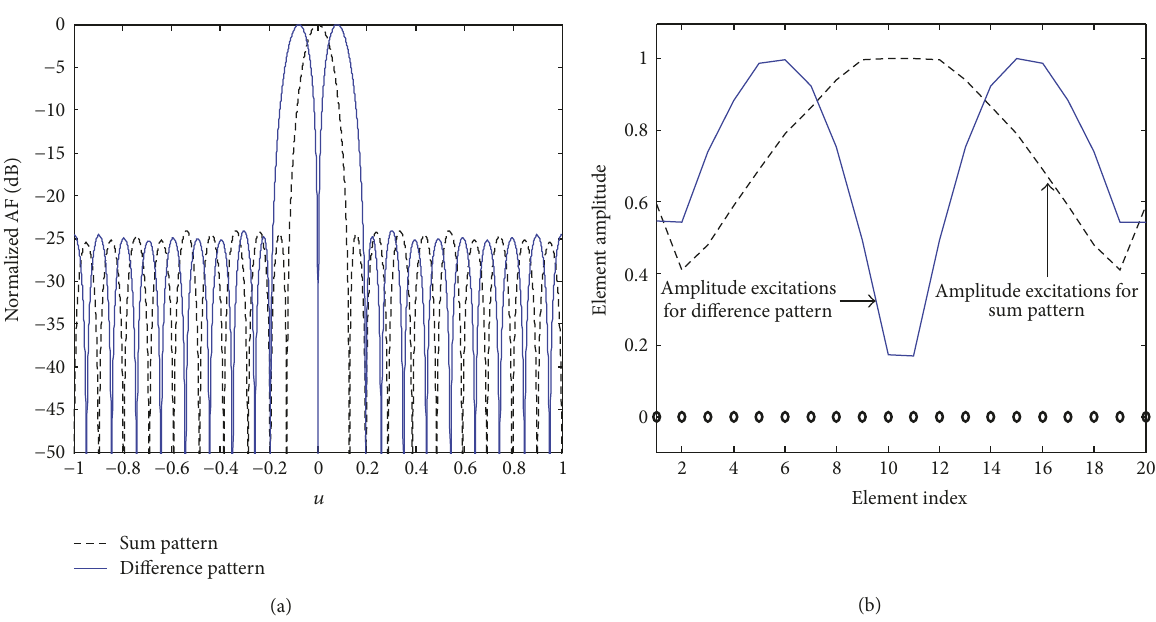
Figure 1: Sum and difference patterns (a) and the corresponding amplitude excitations (b) for the case of no common excitation and 𝑁 = 20